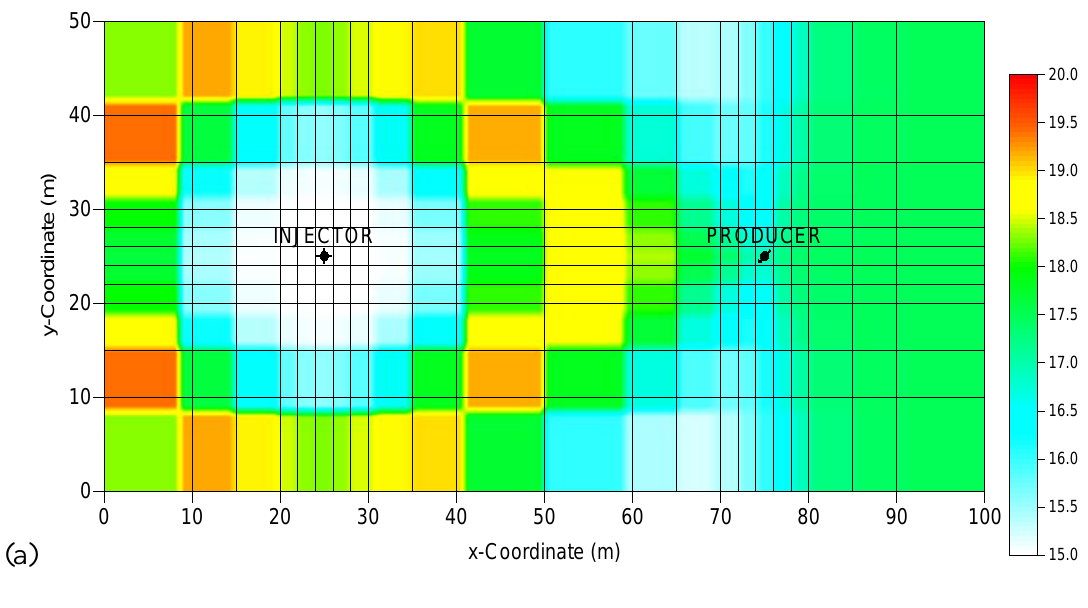
Figure 3. Temperature distribution [°C] obtained with different groundwater flow after cold water injection. (a) no groundwater flow. (b) groundwater flow from right to left ( p ∆ = − 40 kPa). (c) groundwater flow from left to right ( p ∆ = 40